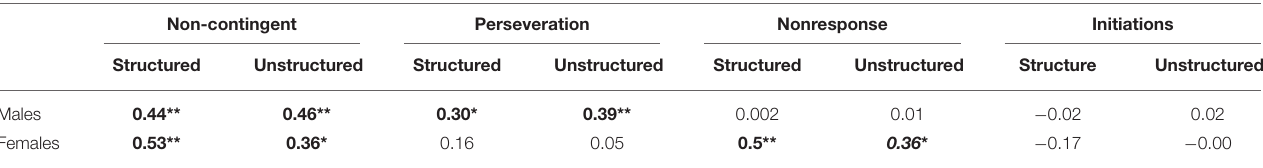
TABLE 3.4 | Partial correlations based on ASD-severity and pragmatic language in